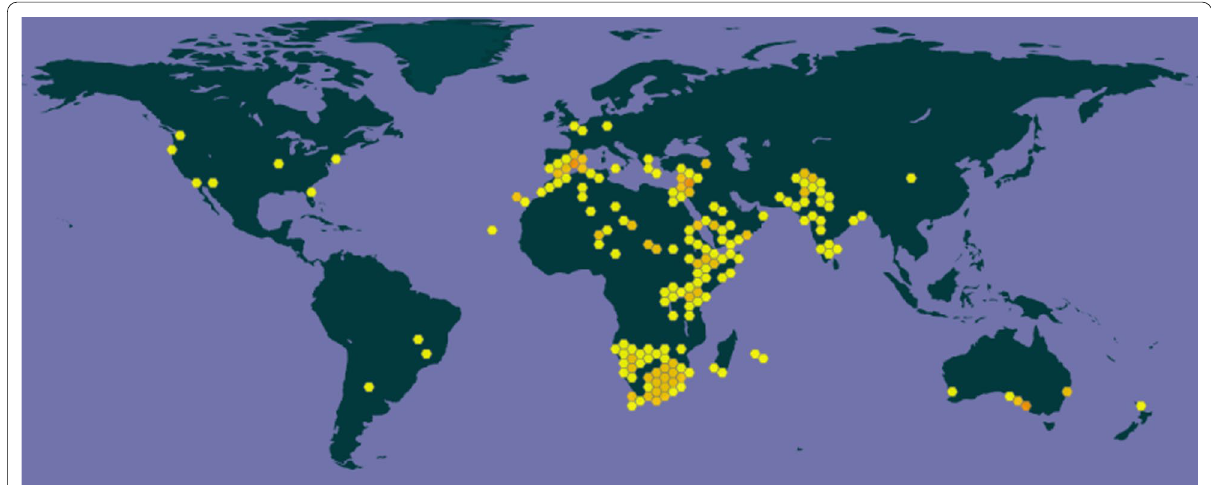
Fig. 1 Ethnographic distribution of W. somnifera ( Withania somnifera (L.) Dunal in GBIF Secretariat 2021)